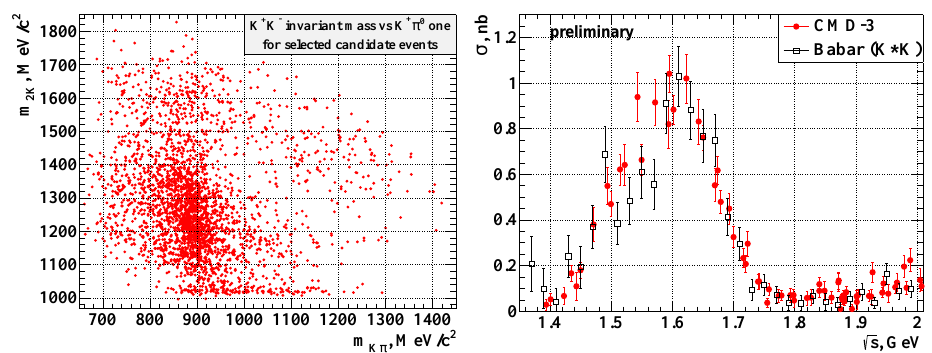
Figure 4. The Dalitz plot distribution for the candi- date events selected in the energy range from 1.38 to 2.01 GeV. The presence of K ∗ K and φπ 0 inter- mediate components is clearly seen.